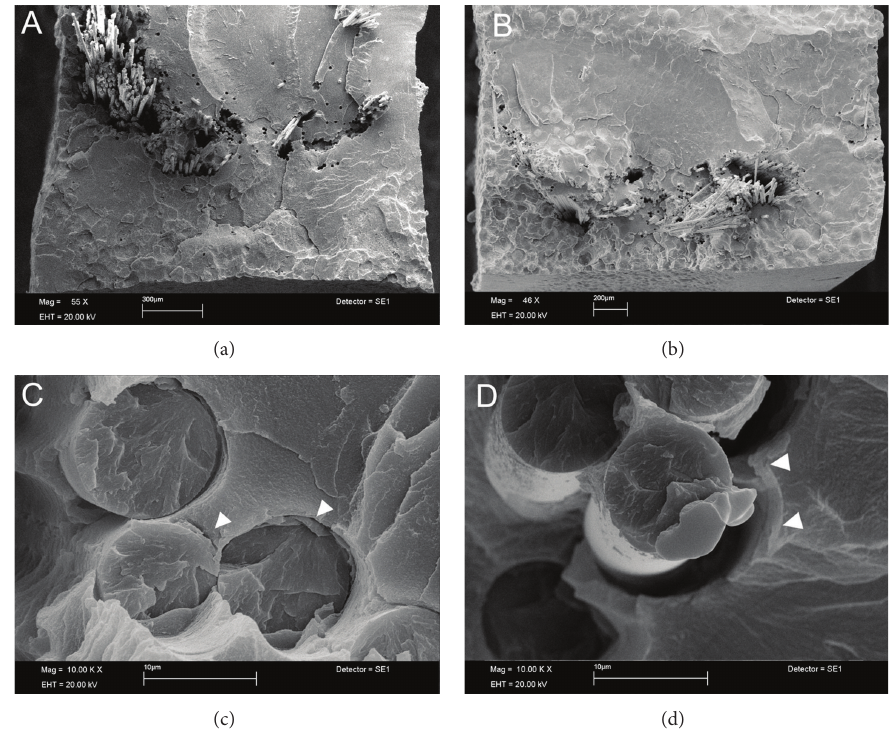
Figure3: Short glassfiber samples. (a)Heat-polymerized resinshowing fiber dislodgement ( × 55magnification). Fiberschanged their original position (tensile stress zone) to neutral stress zone possibly due to applied pressure during heat polymerization. (b) Self-polymerized resin showing lower fiber dislodgement, which could be found at tensile stress zone ( × 46 magnification). (c) Higher magnification ( × 10,000 magnification) of heat-polymerized specimen showing fibers close to resin and with clear signals of adhesion to resin matrix (arrow). (d) Higher magnification ( × 10,000 magnification) of self-polymerized specimen showing space between fibers and resin as a result of the decrease of adhesive interaction (arrows).